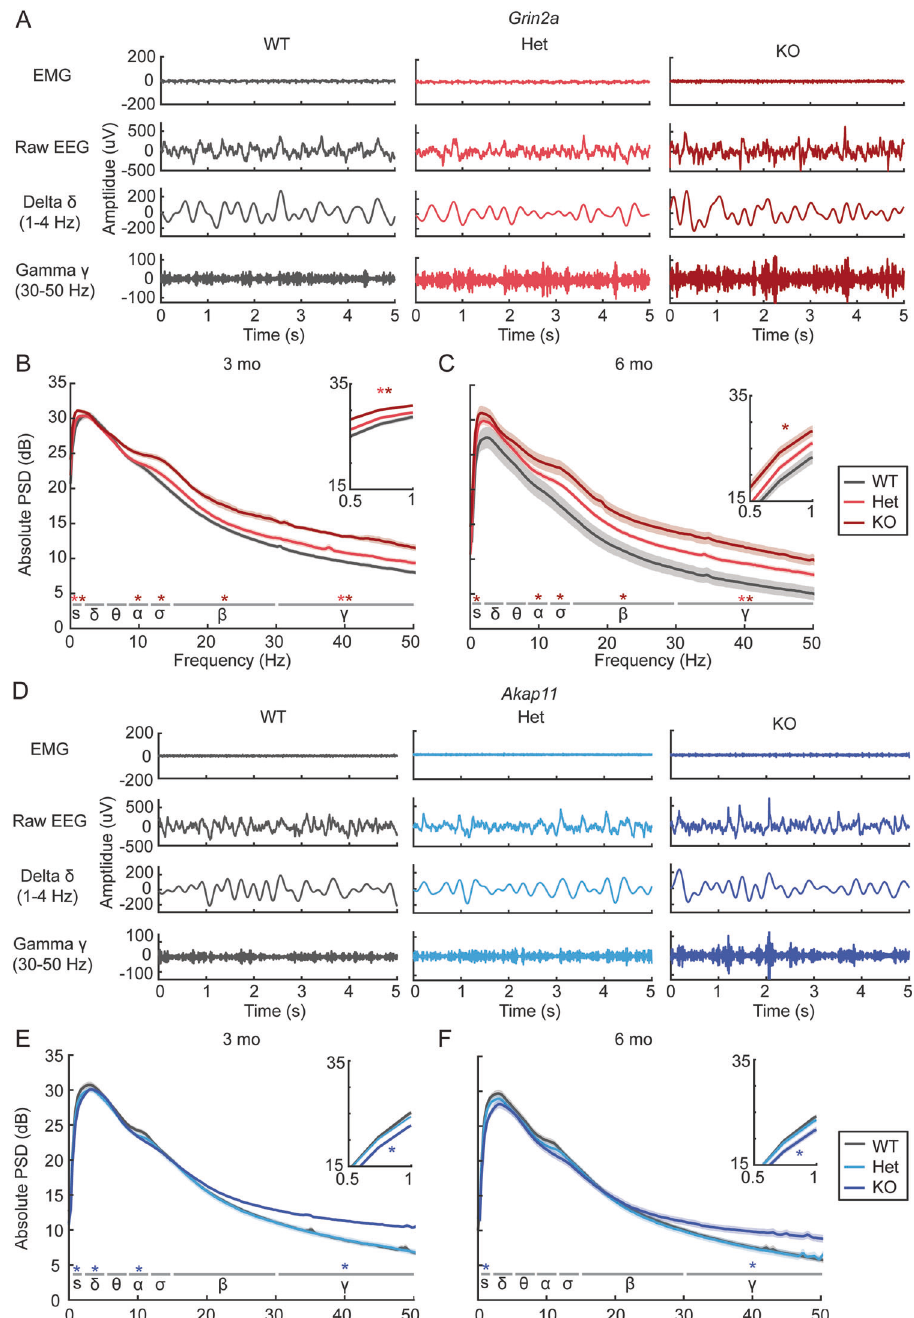
Fig. 3 Power spectral analysis of brain oscillations in Grin2a and Akap11 mutant mice during NREM sleep. A Representative EMG and EEG (raw, delta- and gamma- fi ltered) traces from Grin2a WT, Het, and KO animals during NREM sleep. B , C Absolute NREM power spectra for 3- and 6-month Grin2a mutants during the light cycle. Light and dark red/blue asterisks indicate oscillations for which + / − and − / − mice, respectively, differed signi fi cantly from WT littermates ( p < 0.05) in each of the frequency bands: slow (s), 0.5 – 1 Hz; delta ( δ ), 1 – 4 Hz; theta ( θ ), 4 – 8 Hz; alpha ( α ), 8 – 12 Hz; sigma ( σ ), 12 – 15 Hz; beta ( β ), 15 – 30 Hz; gamma ( γ ), 30 – 50 Hz. Shading indicates mean ± standard error. Insets show magni fi ed view of the graph in the slow oscillation range (0.5 – 1 Hz). n = 11 – 12 mice/group. D Representative EMG and EEG traces from Akap11 WT, Het and KO animals during NREM sleep. E , F Absolute NREM power spectra for 3- and 6-month Akap11 mutants during the light components MMN and P3a, compared with healthy comparison comparing the event-related potentials in response to infrequent subjects [47, 49, 50]. These differential responses are thought to stimuli (deviant, 10% occurrence) vs. frequent stimuli (standard, re fl ect de fi cits in sensory discrimination and novelty-related 90% occurrence) that differ by at least one parameter (e.g., attention shifts, respectively. We found that Grin2a and Akap11 frequency, duration, or amplitude) [47, 48]. Schizophrenia patients KO exhibited altered responses to auditory stimuli during the display reduced responses to unexpected auditory stimuli, as MMN paradigm (Fig. 6). Grin2a − / − animals at 6 months (but not re fl ected by the decreased amplitude of event-related potential